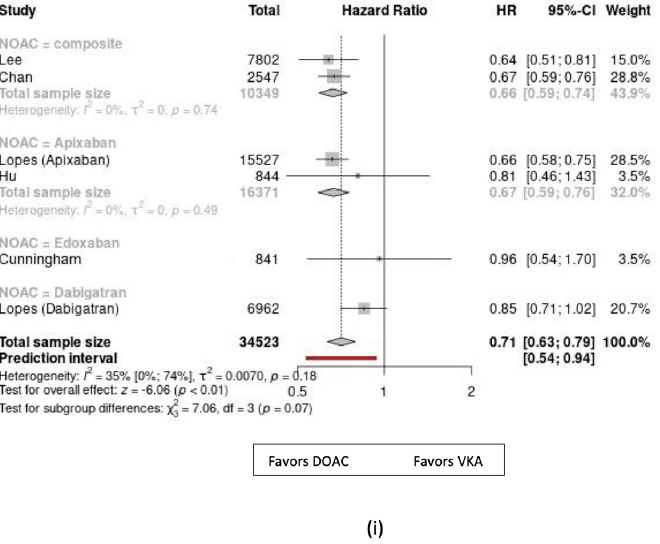
Figure 3. Results: ( a ) major adverse limb events (MALE); ( b ) need for revascularization; ( c ) Figure stroke/systemic embolism; ( d ) myocardial infarction; ( e ) all-cause mortality; ( f ) cardiovascular mor- tality; ( g ) major bleeding (all DOACs); ( h ) major bleeding–rivaroxaban (15/20 mg daily); ( i ) major bleeding–apixaban, dabigatran, edoxaban at conventional doses, and rivaroxaban at reduced doses (2.5 or 5 mg daily).